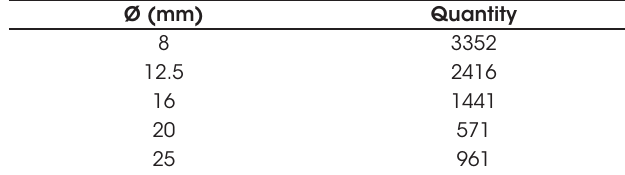
Quantification of specimens by reinforcing bar